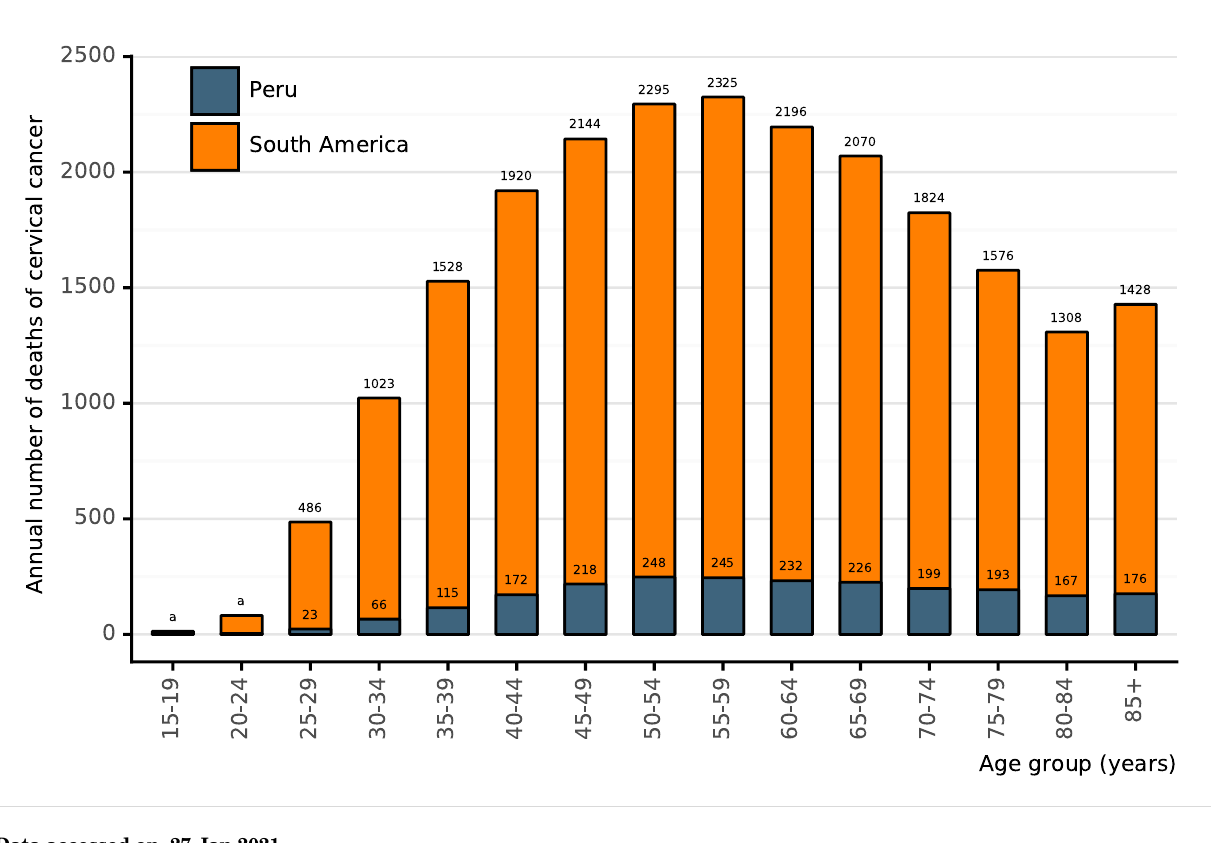
Figure 106: Annual number of deaths of cervical cancer by age group in Peru (estimates for